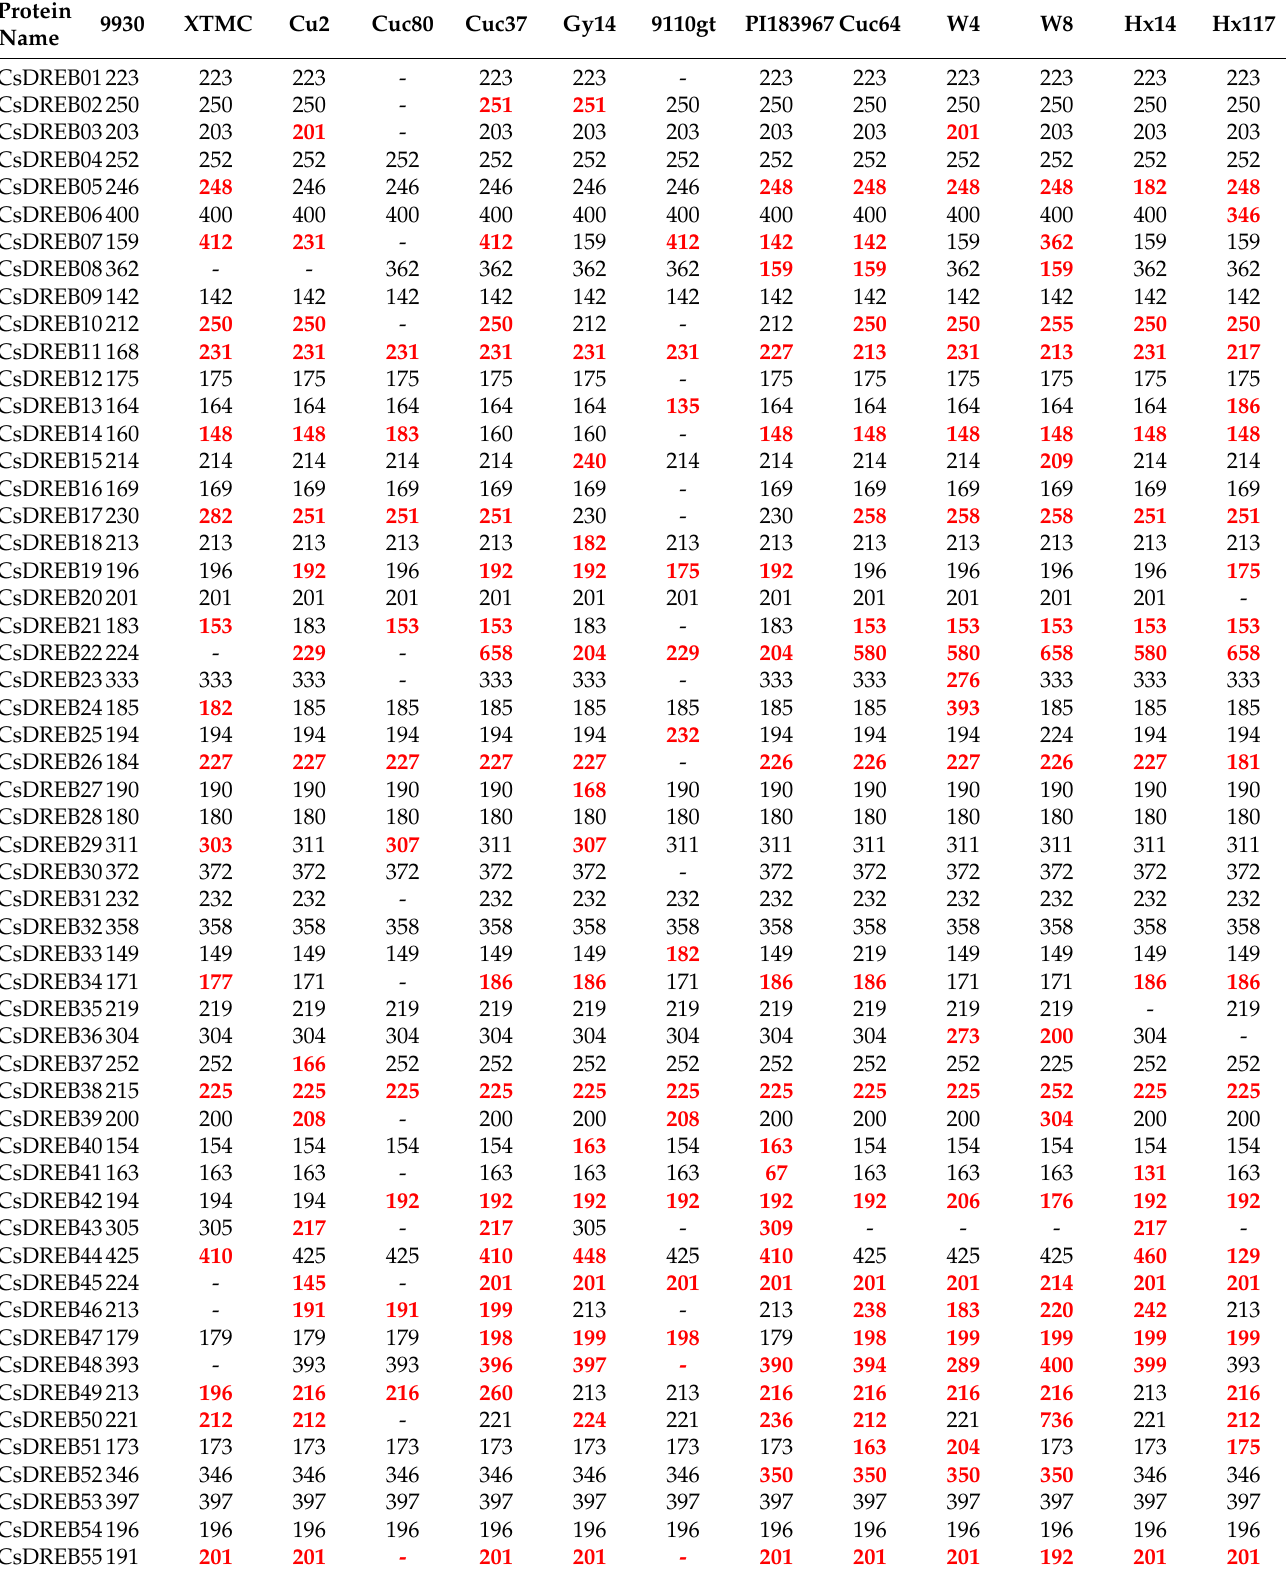
Table 2. The protein lengths of CsDREBs in different cucumber